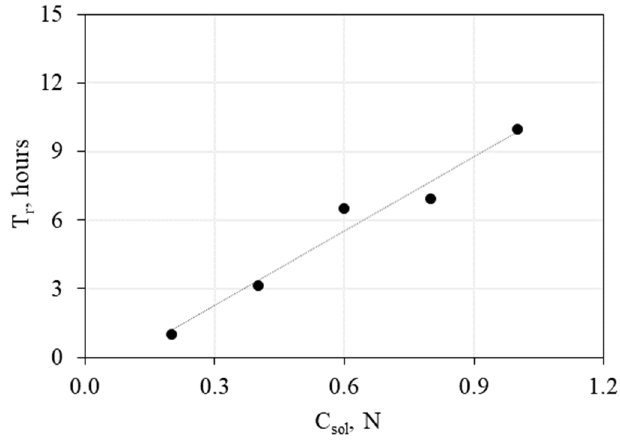
Figure 10. Temperature recovery in frozen hydrate-saturated sand as a function of NaCl concentra- tion ( С sol from 0.1 to 1.0 N; t in = − 6.5 ° С , p = 0.1